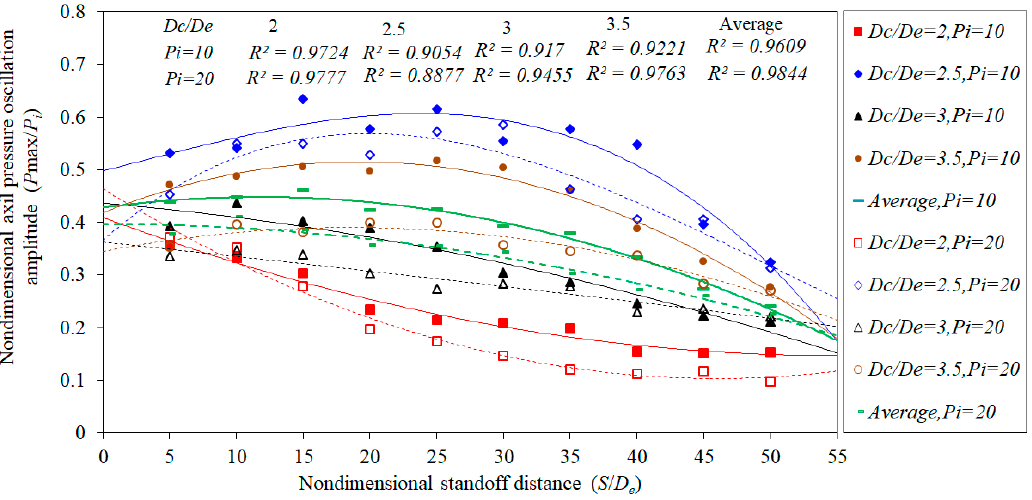
Figure 7. The dimensionless pressure oscillation amplitude against dimensionless standoff distance.